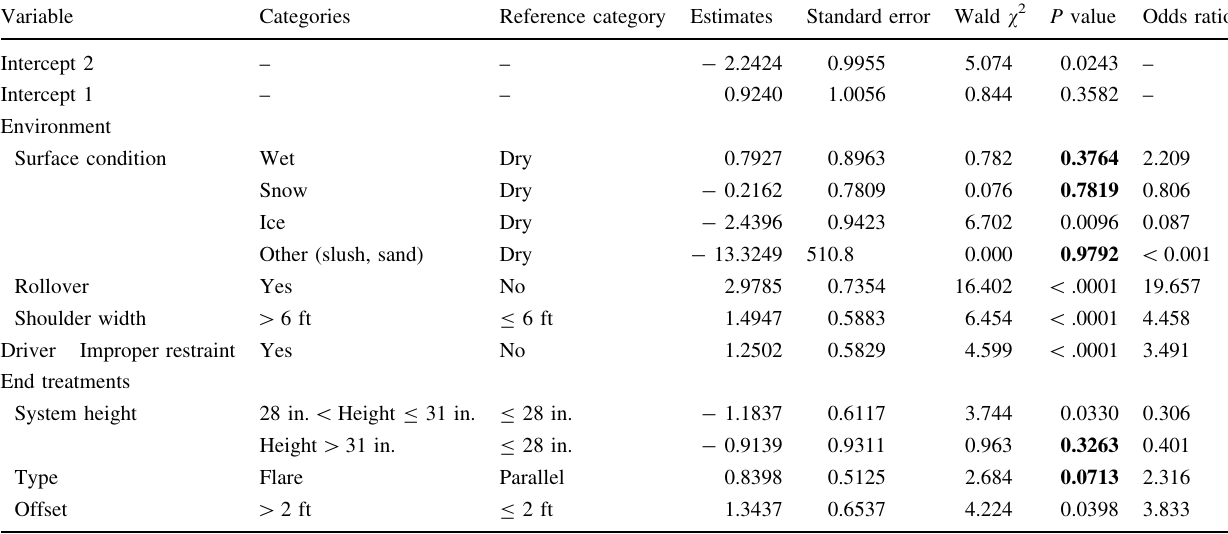
Table 4 Ordered logistic regression for severity of crashes involving end treatments